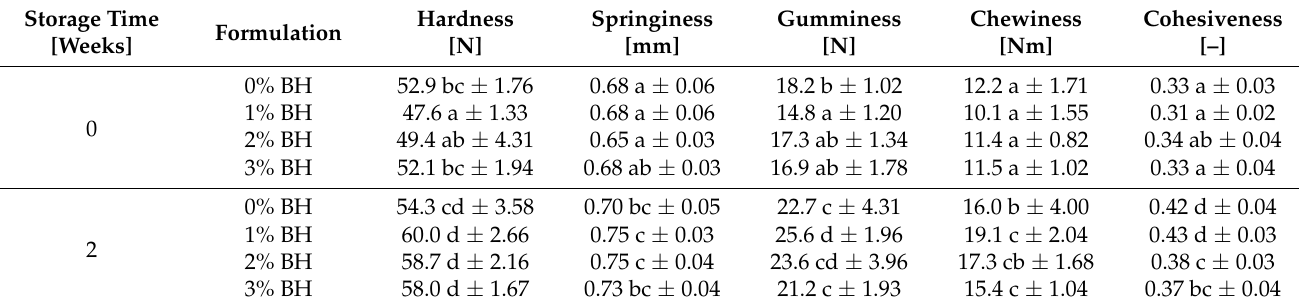
Table 3. Effect of BH on texture parameters of